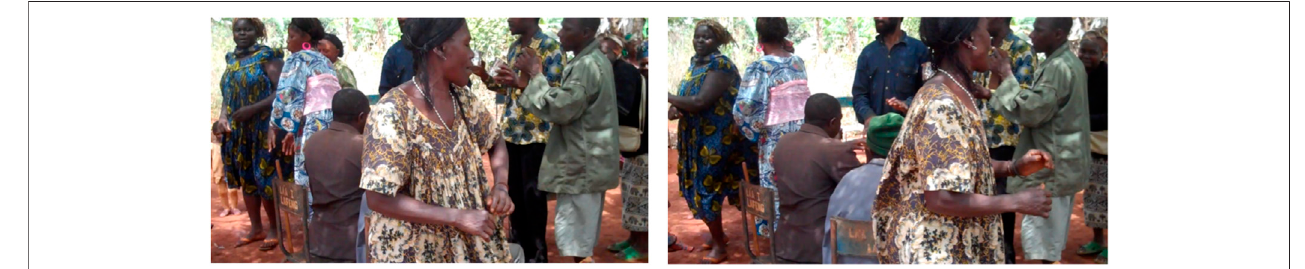
FIGURE 5 | Dancers ’ swing arms back and forth for very attack of the idiophone and